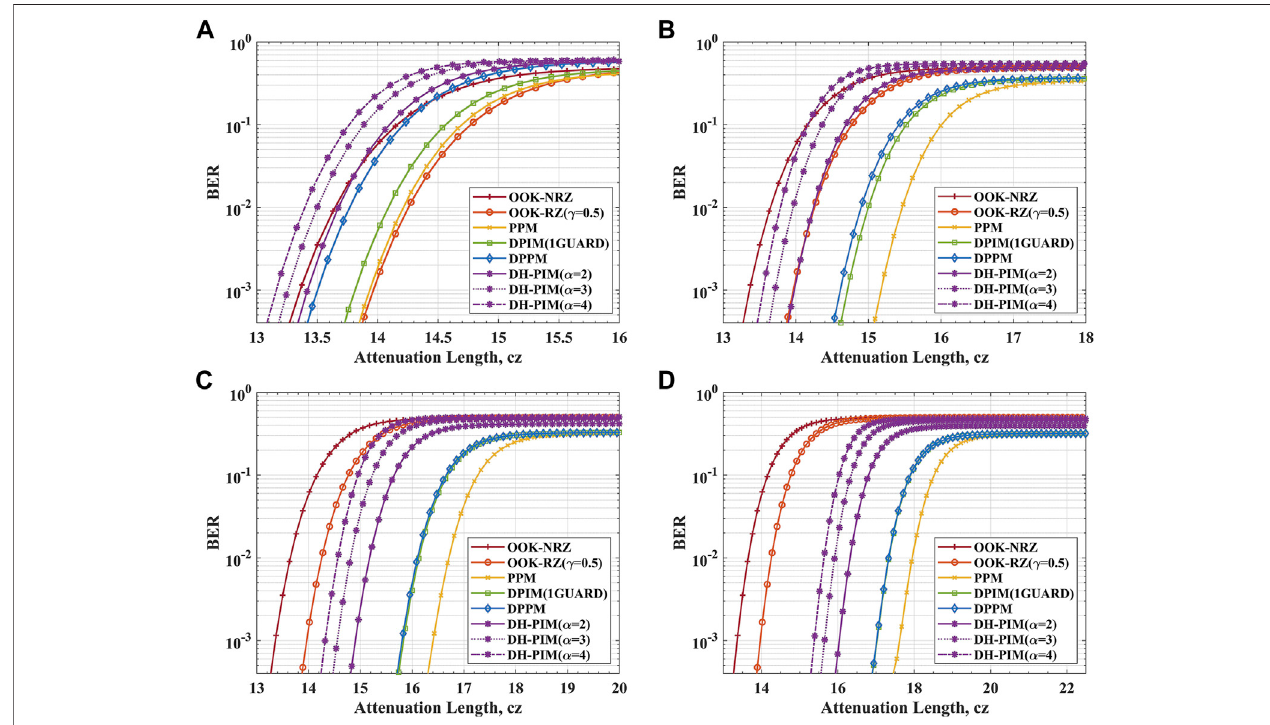
FIGURE 3 | The BER against the attenuation length for UPCC system in the pure seawater channel when T s (cid:1) 15 τ . The communication performance of UPCC systems under several modulation schemes when (A) M = 2 and (B) M = 4, (C) M = 6, (D) M = 8, respectively.